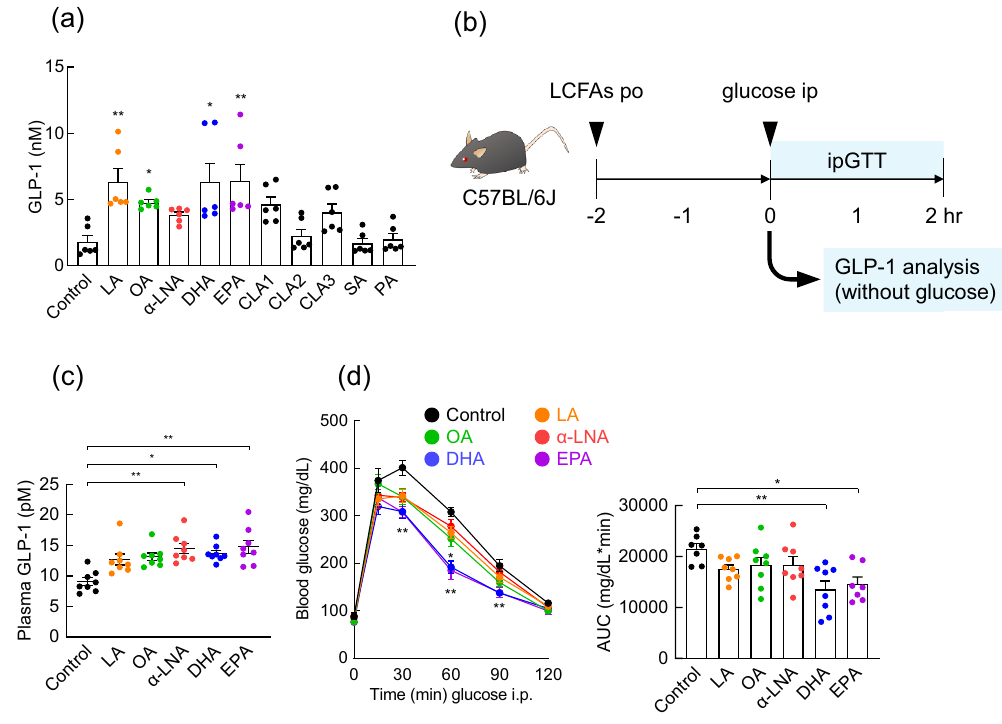
Figure 1. Acute administration of PUFAs improved glucose metabolism by promoting GLP-1 secretion. ( a ) GLP-1 secretion in the STC-1 cells treated with each LCFA (n = 6 per group). ** P < 0.01; * P < 0.05, vs. Control (Dunn’s test). ( b ) Experimental scheme. ( c ) Each mouse was administered LCFAs by oral gavage. After 2 h, the plasma GLP-1 levels were measured (n = 8 mice for each group). ** P < 0.01; * P < 0.05, vs Control (Dunn’s test). ( d ) Each mouse was administered LCFAs by oral gavage. ipGTT was evaluated ( left panel ) and area under the curve (AUC) of ipGTT was calculated ( right panel ) after 2 h (n = 7–8 mice for each group). ** P < 0.01; * P < 0.05, vs. Control (Dunn’s test for 0, 15, and 30 min and Dunnett test for 60, 90, 120 min, and AUC). Results are presented as means ± standard